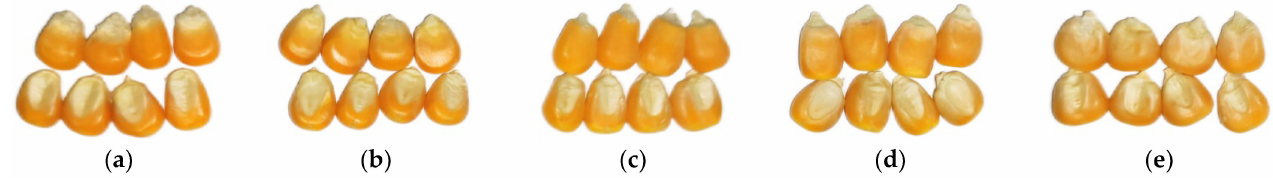
Figure 1. Pictures of five kinds of corn seeds; ( a ) 2490; ( b ) 2780; ( c ) GD5; ( d ) XX8; ( e )